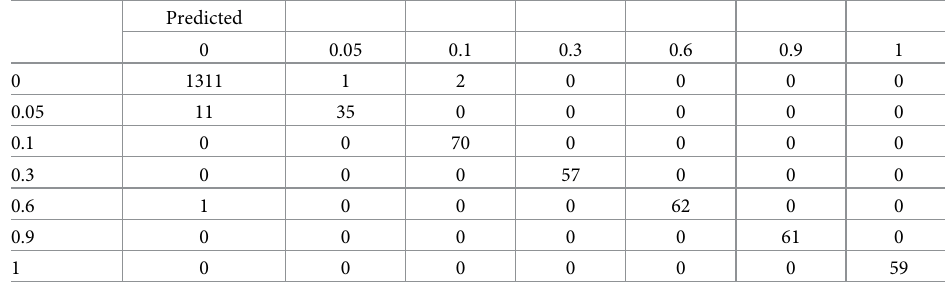
Table 5. Multinomial logistic regression on spectral data obtained from C57BL/6 mice only. Data was classified based on degree of fibrosis (regional pathology grades).